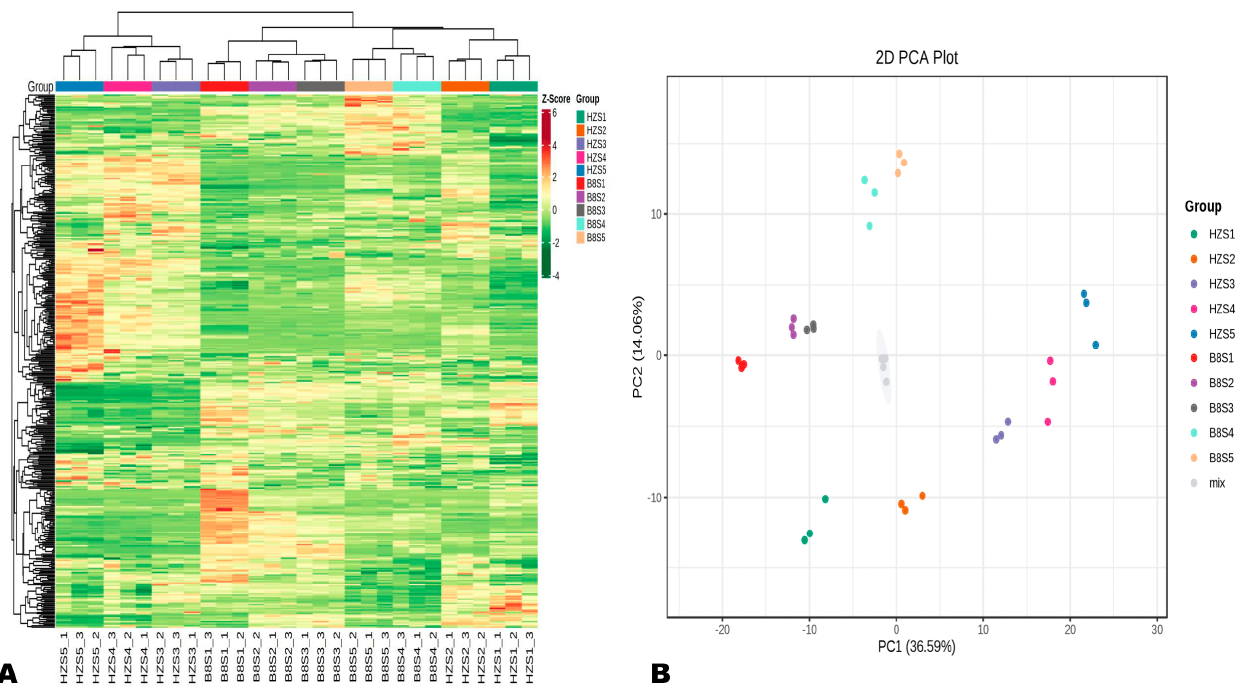
Figure 2. Overview of dynamic changes and variation in HZ and B8 pulps’ metabolome during fruit ripening. ( A ) Hierarchical cluster analysis (HCA) results exposing variation between and within the groups. ( B ) Principal component analysis (PCA) results showing metabolite profile differences between and within the groups.